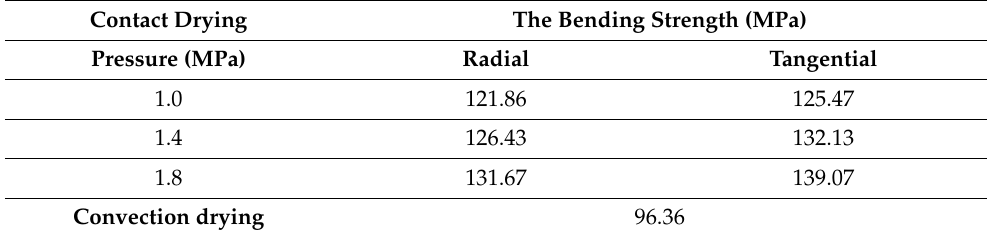
Convection drying